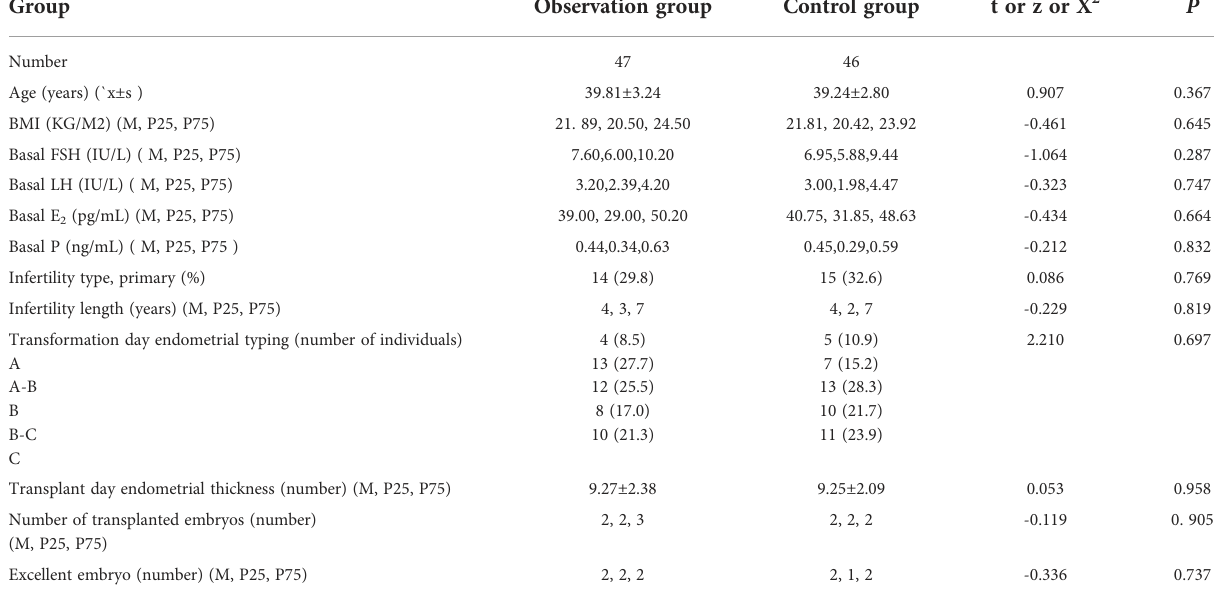
TABLE 1 Comparison of basic situation between two groups of patients. Group